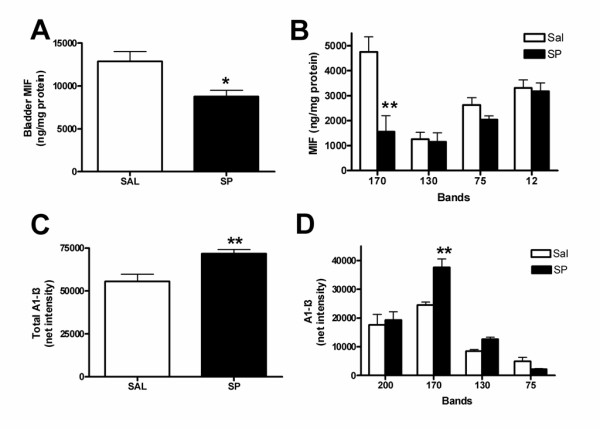
Effect of Substance P-treatment on specific MIF/A1-I3 complexes. Substance P treatment decreased the total MIF detected in bladder homogenates (using WB under non-reducing conditions) and this decrease was statistically significant (A). In addition, examining the changes in individual bands (under non-reducing conditions) showed that substance P treatment caused a significant decrease in the 170-kDa band in bladder homogenates, while changes in other bands did not reach statistical significance (B). SP treatment also increased the total amount of A1-I3 in the bladder, presumably due to plasma extravasation (C). In particular, the 170-kDa A1-I3 band was significantly increased (D). * = p < 0.05; ** = p < 0.01.